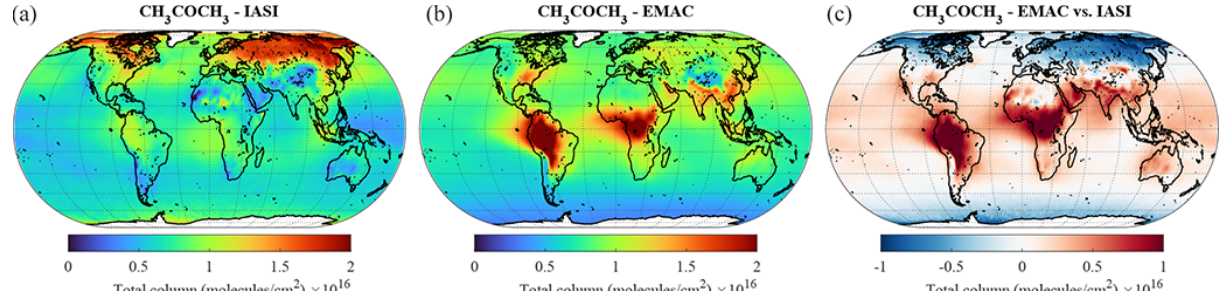
Figure 11. The same as Fig. 8 but for CH 3 COCH 3